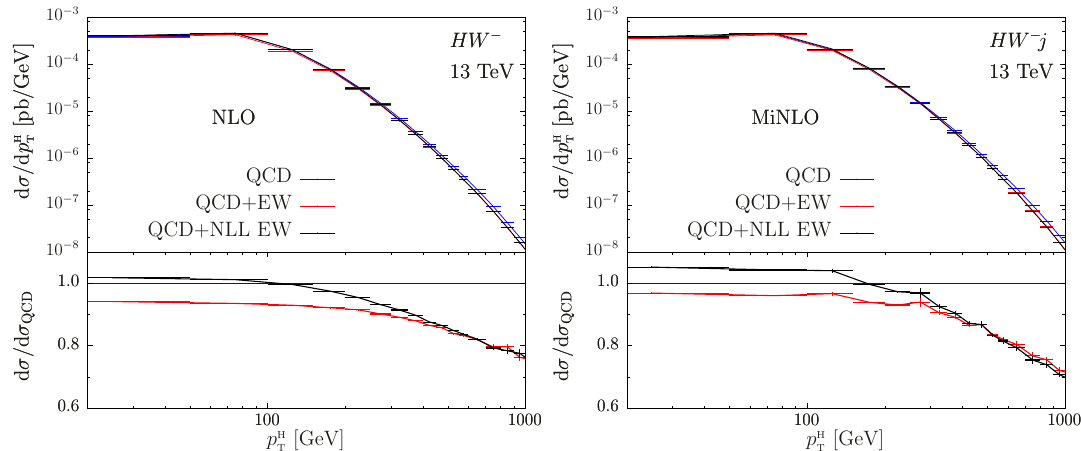
Figure 4. NLO predictions for the transverse momentum of the Higgs boson in HW (cid:0) (left) and HW (cid:0) j (right) production. Predictions and labels as in (cid:12)gure 3.